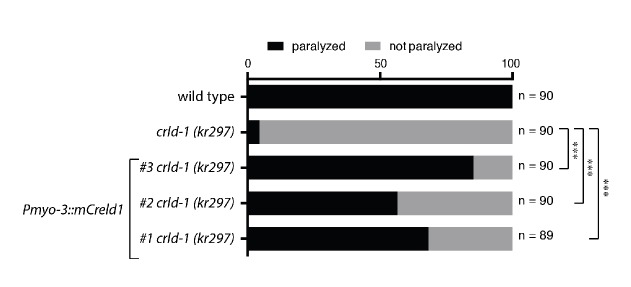
Mouse Creld1 rescues levamisole-sensitivity of crld-1 mutant worms.Expression of mouse Creld1 in C. elegans muscle cells under the control of the Pmyo-3 promoter rescues levamisole sensitivity in kr297 mutants. Gray bars indicate the percentage of moving animals after overnight exposure to 1 mM levamisole, and black bars indicate the percentage of paralyzed animals. three independent transgenic lines were tested. Experiment was repeated three times, n = number of animals tested. ***p<0.001, after Bonferroni correction, Fisher exact probability test.